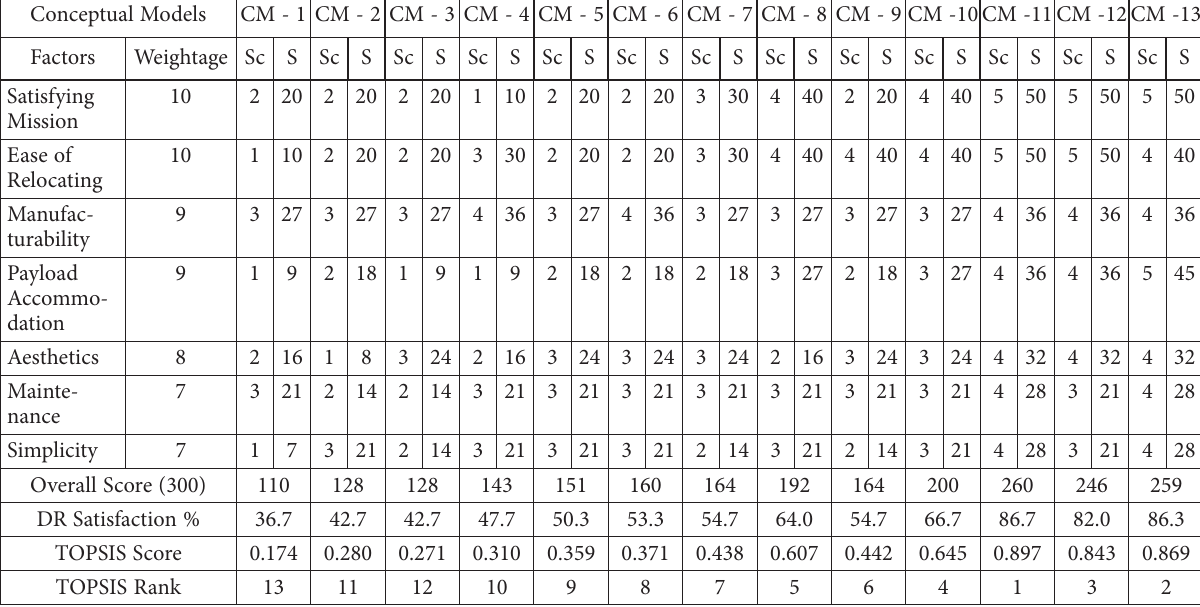
Table A5. Design selections of conceptual models by Pugh’s